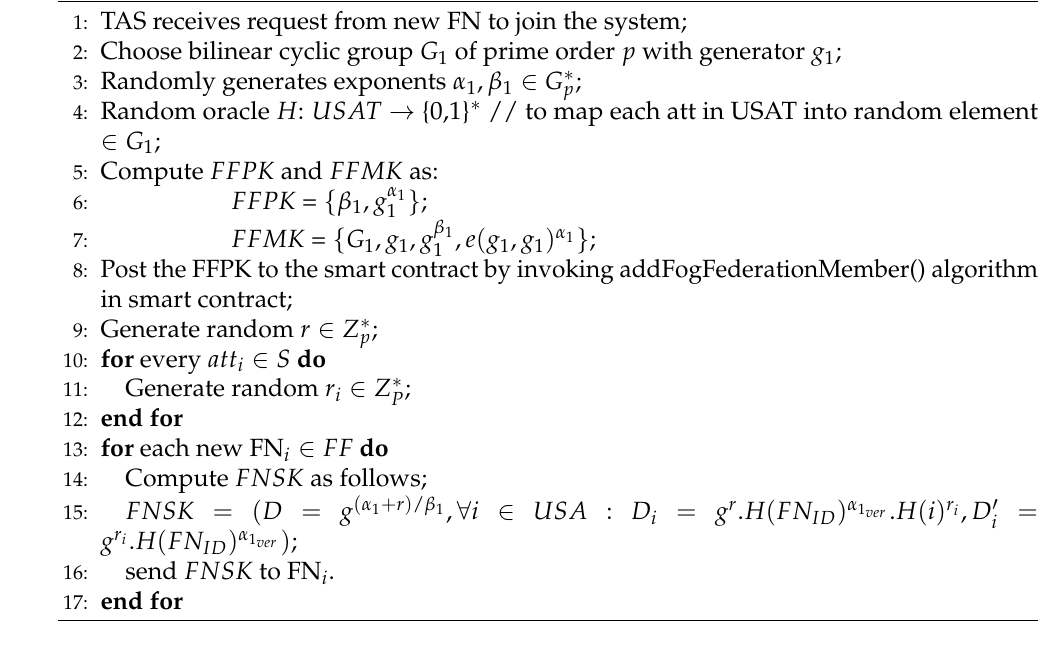
Algorithm 3 Generating FNSK ( SPK , SMK , S , FN ID ).